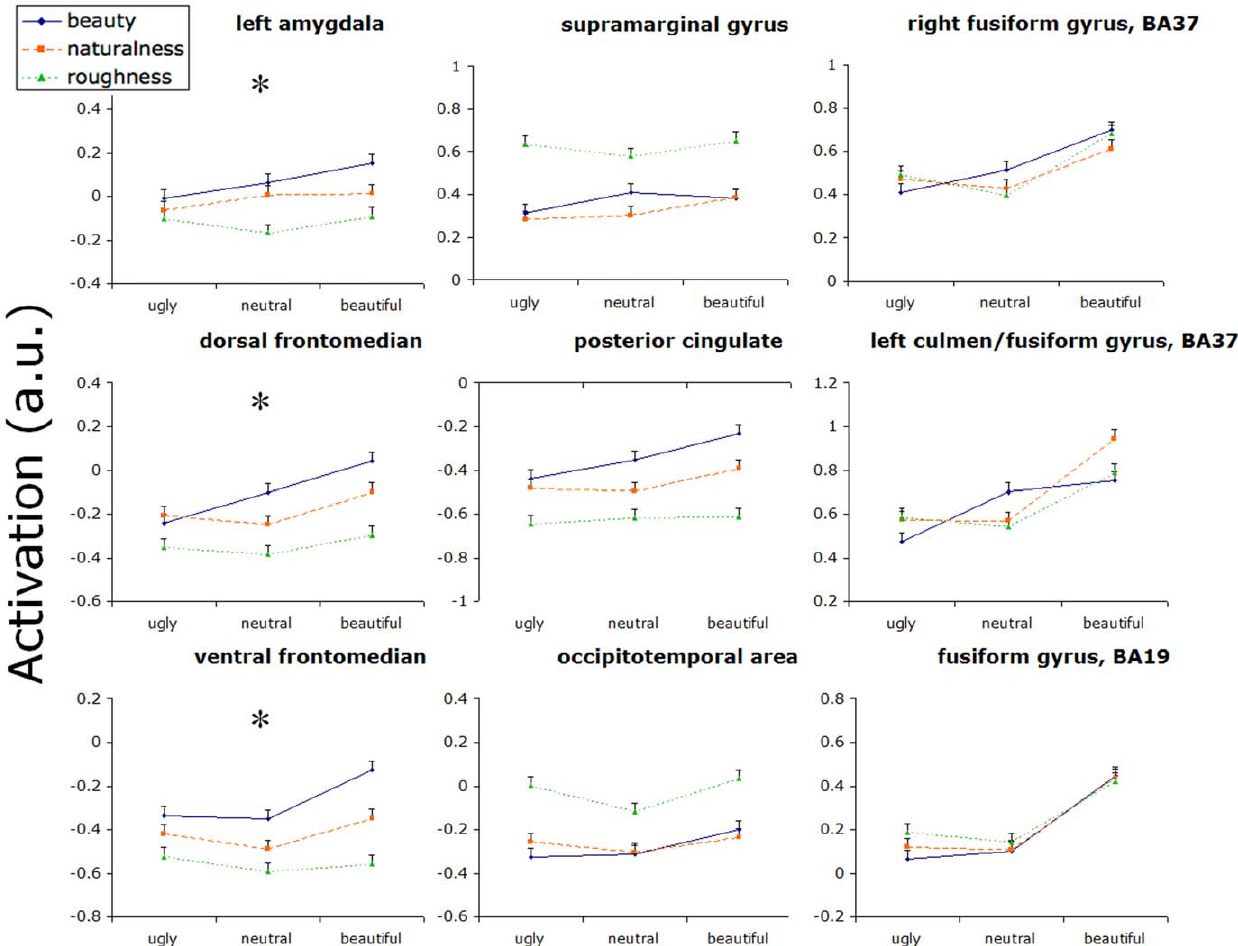
Figure 3. Activations in response to beautiful, neutral and ugly textures during beauty, naturalness and roughness judgments. Most regions-of-interest demonstrate significant interactions between beauty versus roughness judgments and beautiful (positive) versus ugly (negative) textures, as indicated by asterisks (*). Error bars indicate the standard error of the mean.